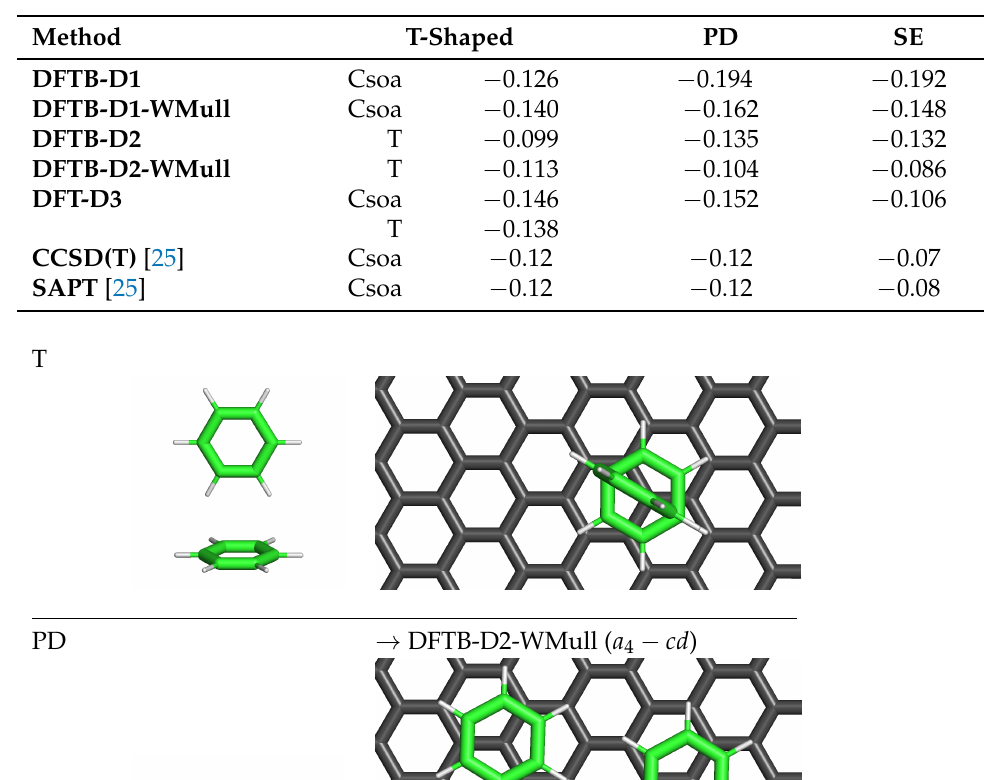
Table 4. Binding energies for benzene dimer bz 2 in eV.